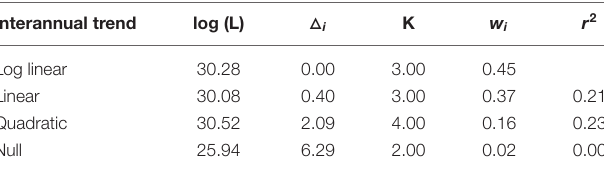
TABLE 3 | Support for models of interannual trends in the Priority Matching Distribution. Interannual